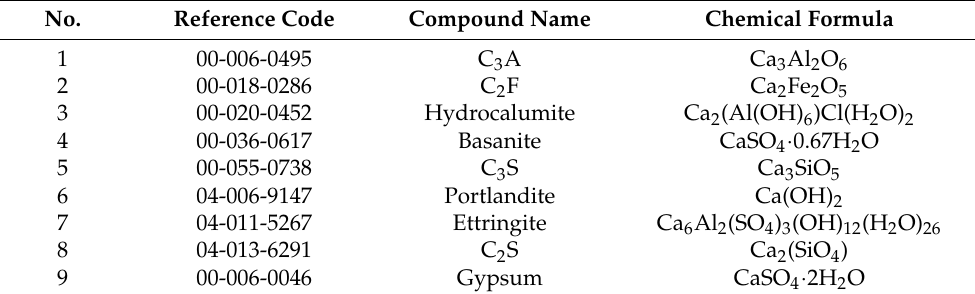
Table 2 . Composition of the C0 and C45 pastes determined from the XRD patterns.